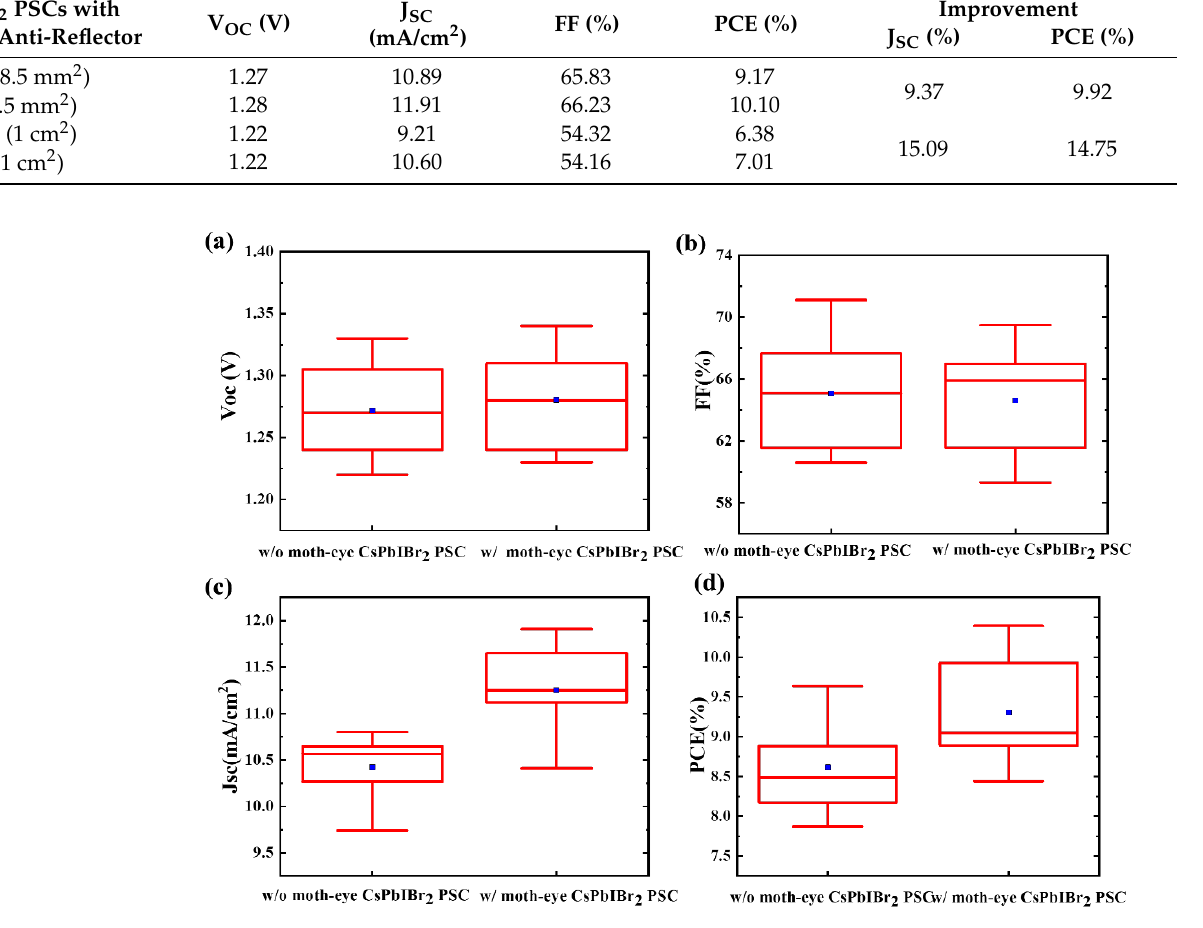
Table 1. Photovoltaic parameters of CsPbIBr 2 PSCs of small and large active areas. CsPbIBr 2 PSCs with